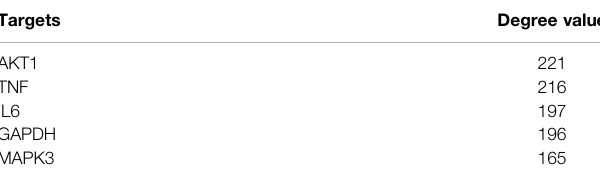
TABLE 1 | Shared key targets of sepsis and